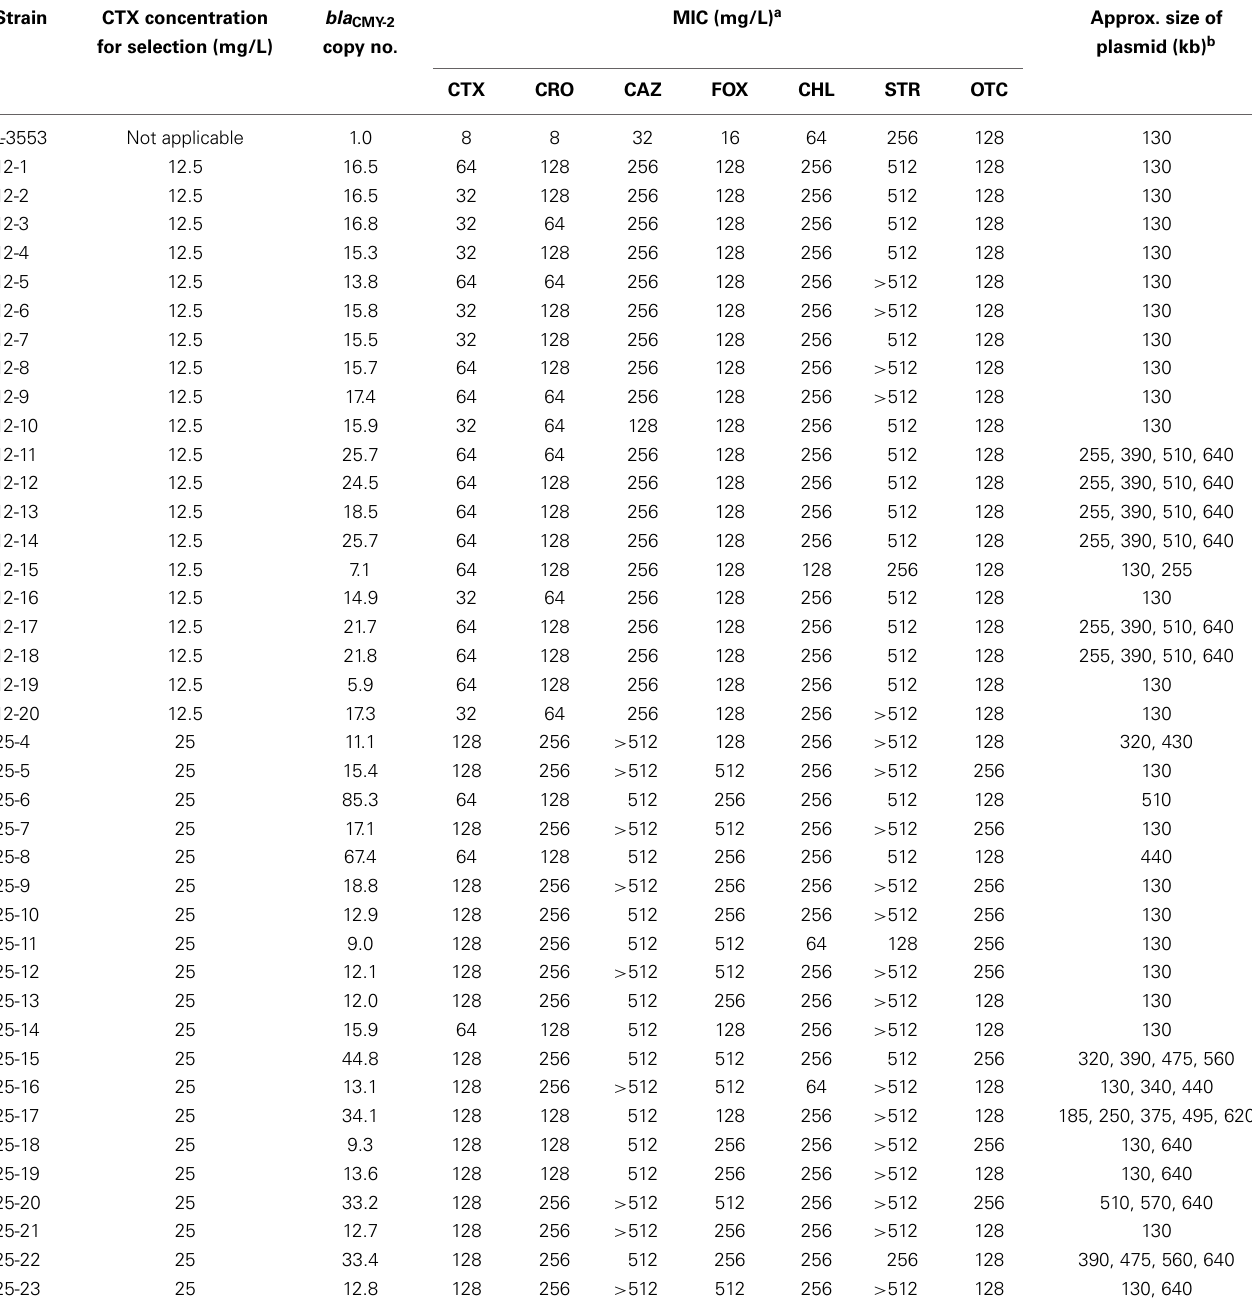
Table 1 | Copy numbers of bla CMY − 2 and MICs of various antimicrobials for S . Typhimurium L-3553 and the spontaneous mutants selected on CTX-containing